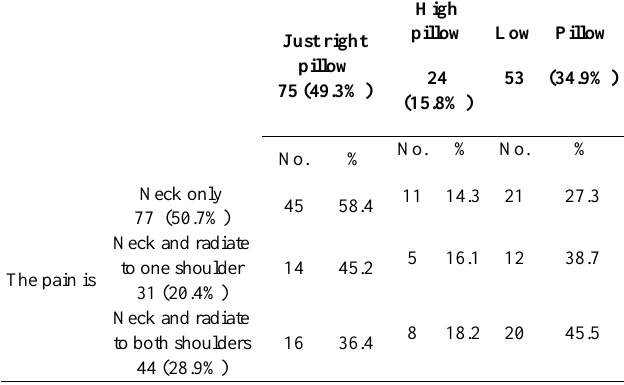
Table (2): Show the correlation between location of pain and pillow’s heights